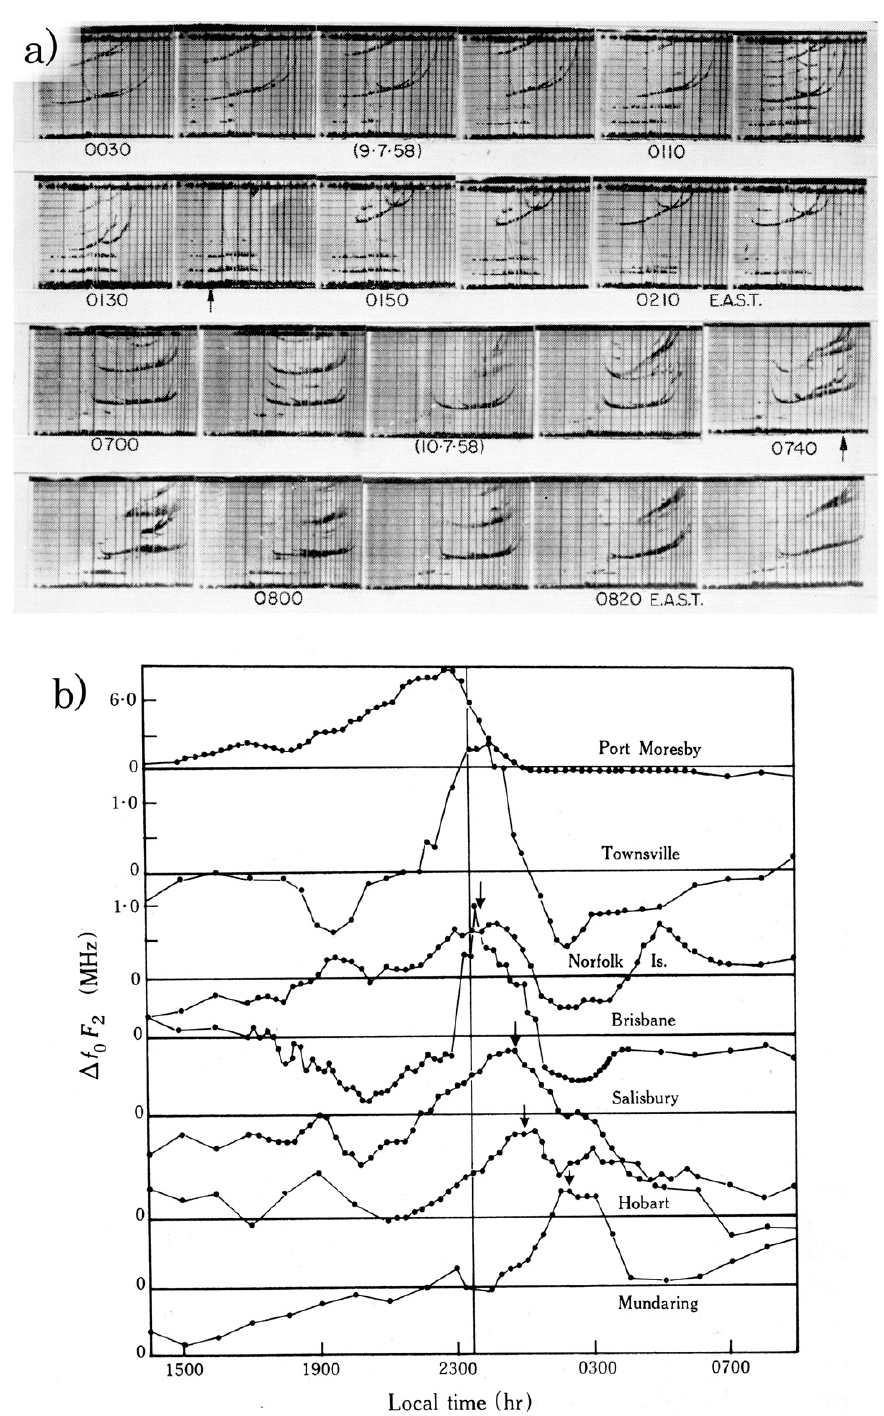
Fig. 2. (a) Reproduction of Fig. 8 of Bowman (1965), showing ionograms related to LS-TIDs recorded 30h apart. It supports the other evidence by Bowman (1965) for encirclements, (b) a reproduction of Fig. 10 of Khan (1970).